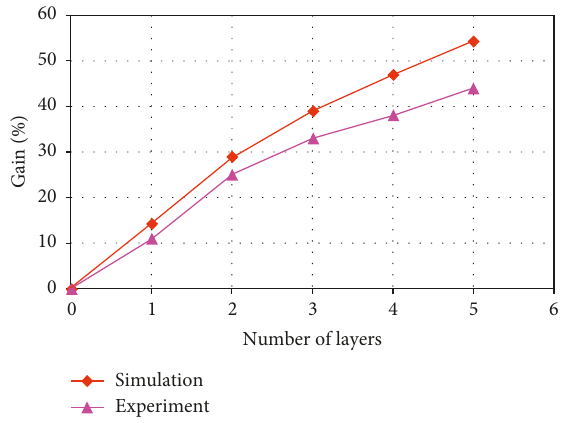
Figure 19: Bearing capacity gain function of the CFRP